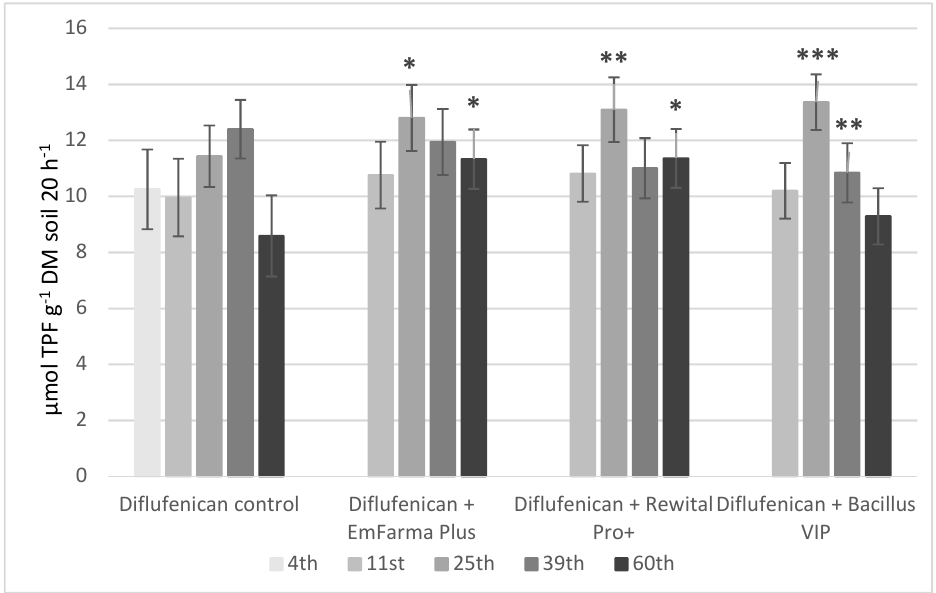
Figure 5. Changes in the DHA of the soil with diflufenican and following application of formulations with EM in time. Statistically significant p values are shown as p < 0.05 (*), p < 0.01 (**) and p < 0.001 (***). Our results confirm that the herbicide or its metabolites may stimulate the activity of microorganisms in the first period, while the activity of DHA decreases with dissipation of the active substance